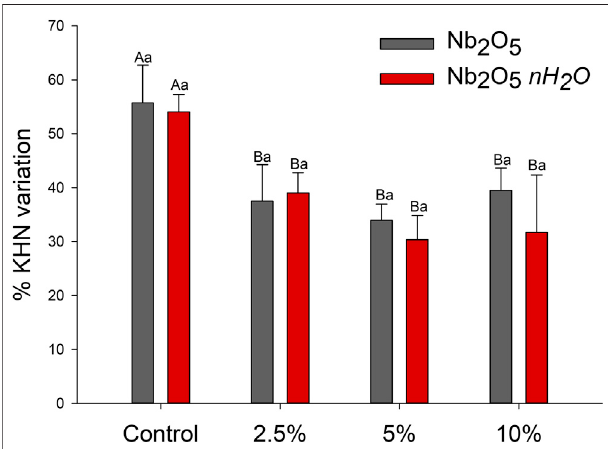
FIGURE 3 | Mean and standard deviation of softening in solvent after immersion in ethanolic solution in percentage of microhardness variation. Different capital letters indicate a statistically signi fi cant difference among the concentrations (0, 2.5, 5, and 10 wt%) for the same type of fi ller (Nb 2 O 5 or Nb 2 O 5 . n H 2 O) ( p < 0.05). Different lowercase letters indicate a statistically signi fi cant difference within the same concentration (0, 2.5, 5, or 10 wt%)